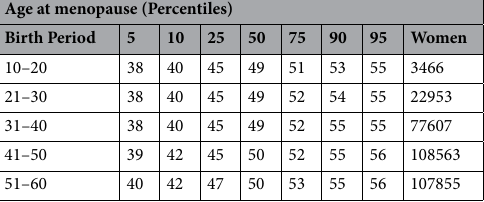
Age at menopause (Percentiles) Birth